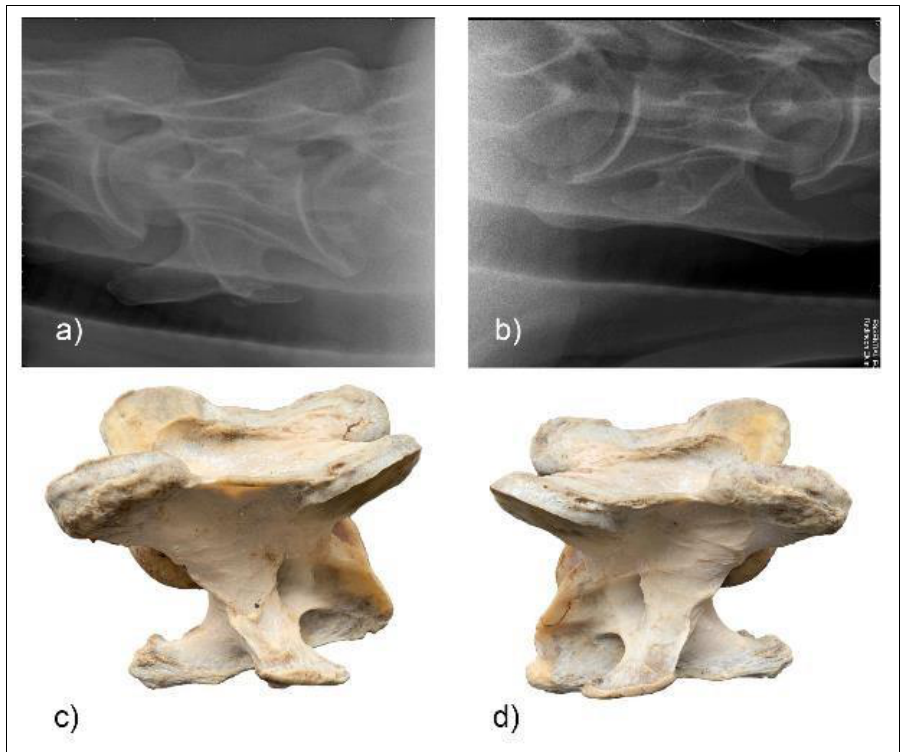
Figure 5. Radiographic images of the lateral 30° dorsal to ventral oblique left ( a ) and right ( b ) of C6 of horse M1 with the vertebrae left ( c ) and right ( d ) below. (Image ( b ) and ( d ) have been left in nonstandard orientation to appreciate the three-dimensional osseous form).